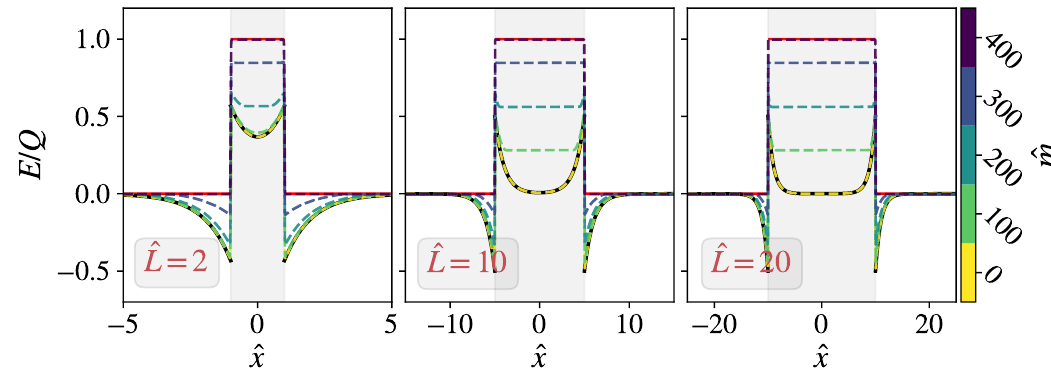
Figure 2 . Numerically obtained asymptotic electric field profiles at the end of capacitor discharge in massive QED for three different plate separations (corresponding to separate panels), and for a 2 range of mass parameter ˆ m (corresponding to the color-coded dashed curved), with ˆ N = 200 . The electric field profile prior to discharge is shown in solid red line. The black solid lines underneath the yellow dashed curves correspond to the analytical result eq. (3.6) in the massless